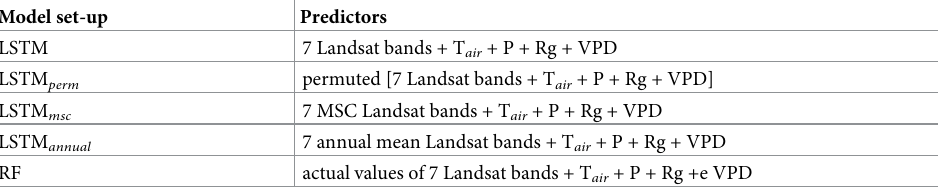
Table 2. List of predictors used in the different model set-ups. T air = air temperature, P = precipitation, Rg = global radiation, and VPD = vapor pressure deficit. LSTM = LSTM model using the full depth of the Landsat time series and climate data; LSTM = LSTM model but the temporal patterns of both the predictive and the target variables were perm randomly permuted while instantaneous relationships between predictive and target variables were kept; LSTM msc = LSTM model but the Landsat time series for each band were replaced by their mean seasonal cycle, while using the actual values of air temperature (T air ), precipitation (P), global radiation (Rg), and vapor pressure deficit (VPD); LSTM annual = LSTM model but the Landsat time series for each band were replaced by their annual mean, while using the actual values of T air , P, Rg, and VPD, RF = Random Forest model using the actual values of the Landsat time series and climate data. Model